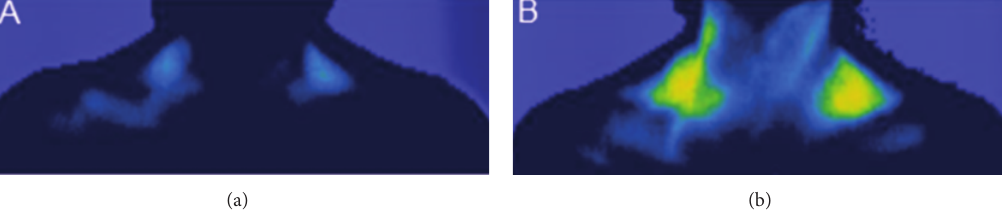
Figure 3: Representative example of thermal images [31] showing the change in temperature of BAT located within the supraclavicular region of a prepubertal 13-year-old child having eaten 25 g of organic porridge oats mixed with 70mL of full fat milk and 8 g of brown sugar. (a) Preprandial control and (b) 5 minutes after-prandial, accompanied with a mean increase in temperature of the supraclavicular region of 0.9 ∘